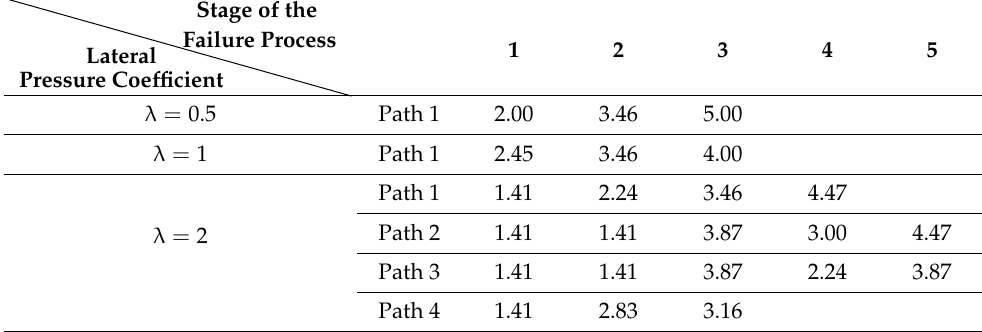
Table 10. The safety state of the tunnel in the failure